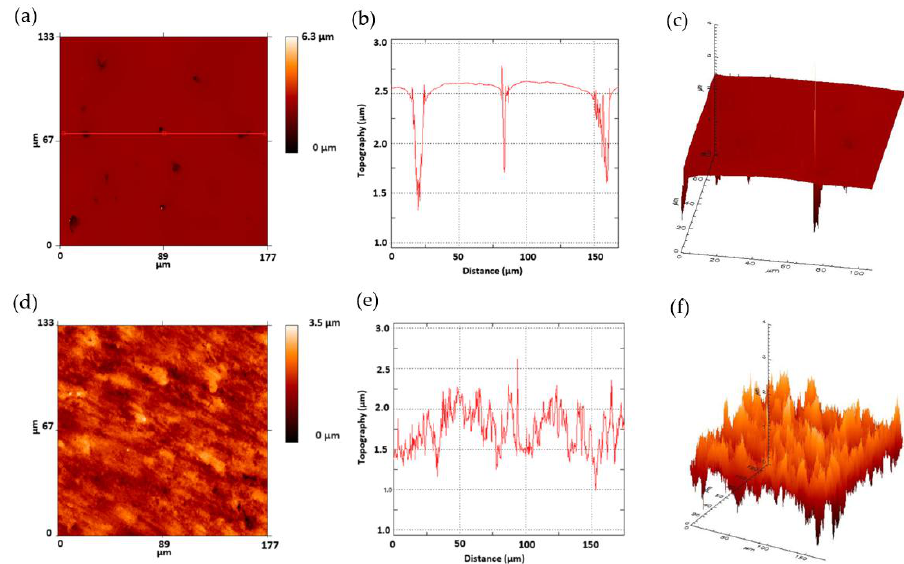
Figure 5. The surface roughness of the Ti35Nb10Ta alloy by confocal microscopy. ( a ) The 2D topographic roughness of the polished sample. ( b ) Roughness line profile of the polished sample. ( c ) The 3D topographic roughness of the polished sample. ( d ) The 2D topographic roughness of the 15 V 45 min nanotube sample. ( e ) Roughness line profile of the 15 V 45 min nanotube sample. ( f ) The 3D topographic roughness of the 15 V 45 min nanotube sample.